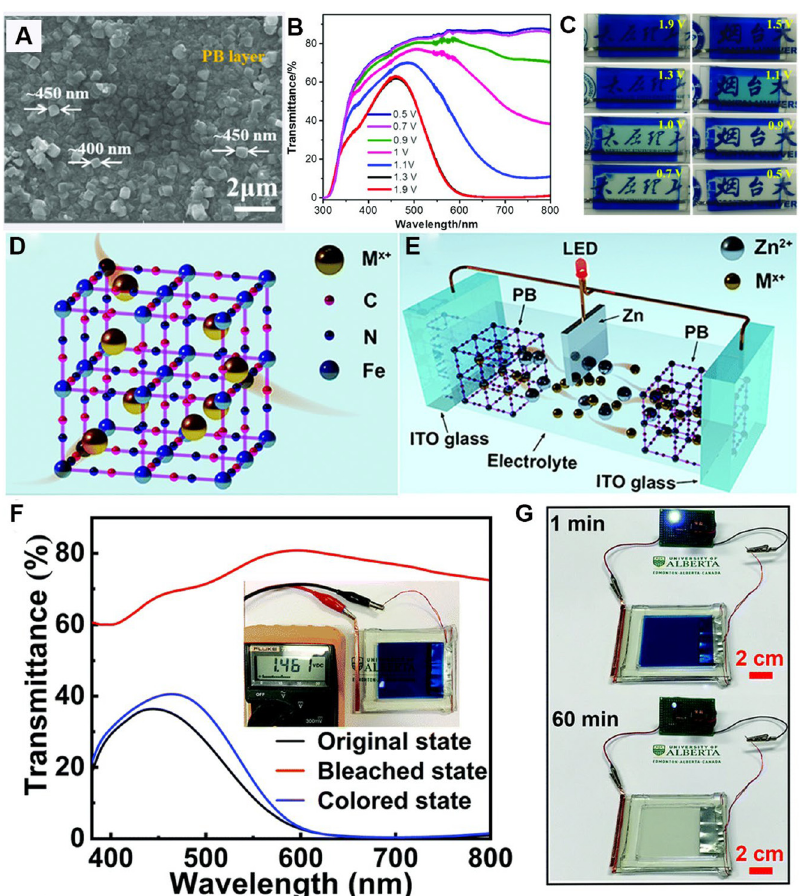
Figure 2: Structure, working principle,